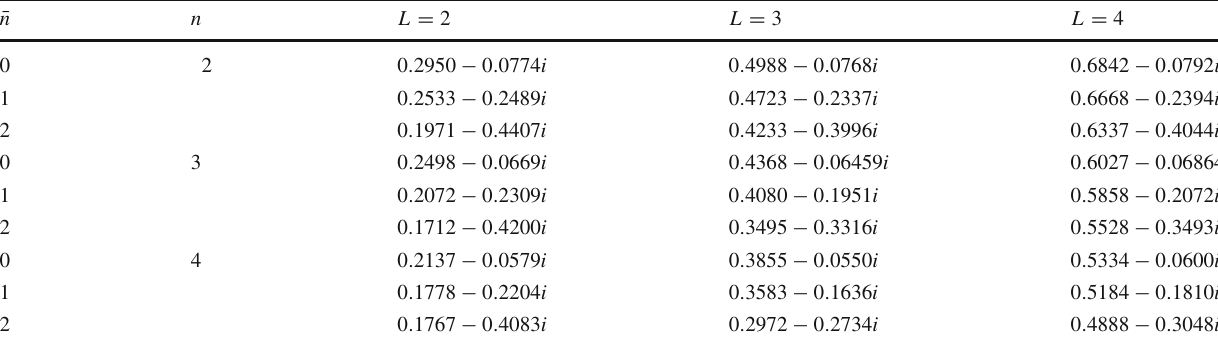
Table 2 The quasinormal frequencies ω/ c T of the metric perturbations. By employing the third-order WKB approximation, the calculations are carried out using the metric parameters m = 1 and c 14 = 0 for different values of n , overtone number ¯ n and angular momentum